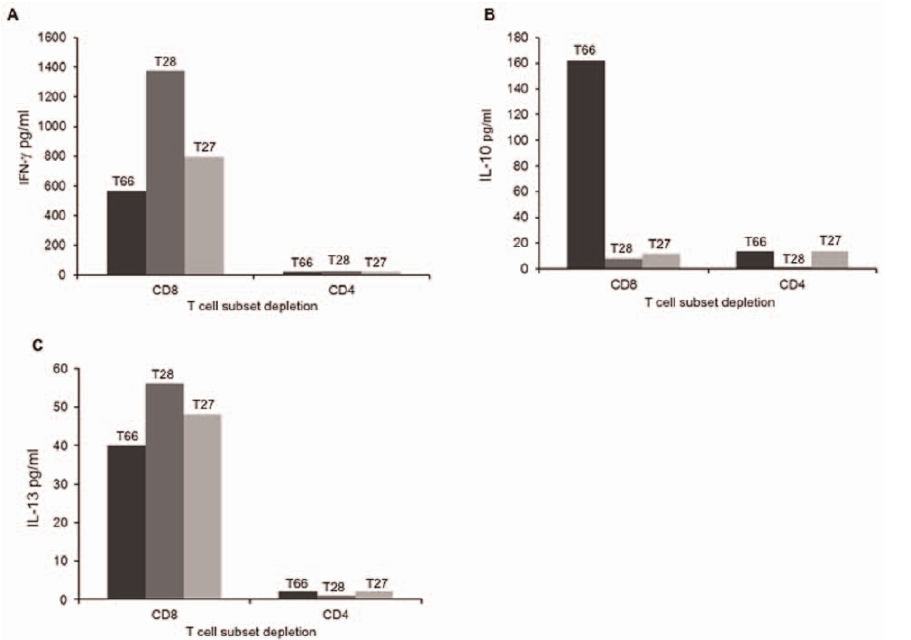
Figure 3. TSV VP1-specific T-cell responses after T-cell subset depletion. PBMC of two TSV seropositive (T66, T28) and one seronegative subject were deplete either of CD4 + or CD8 + T cells and stimulated with TSV VP1-VLPs (1.5 m g/ml). IFN- c (A), IL-10 (B) and IL-13 (C) were studied by ELISA.